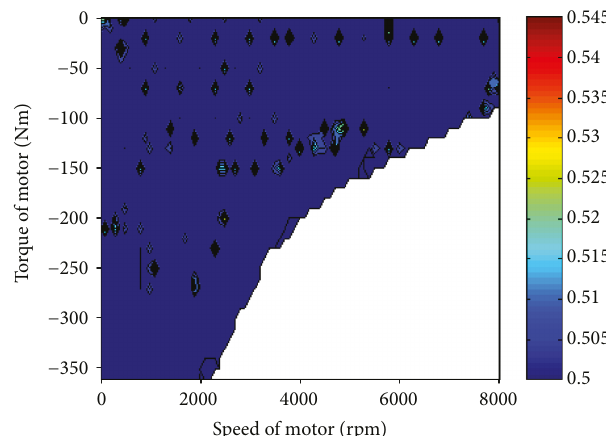
Figure 9: Optimal distribution coe ffi cient of regenerative braking torque.